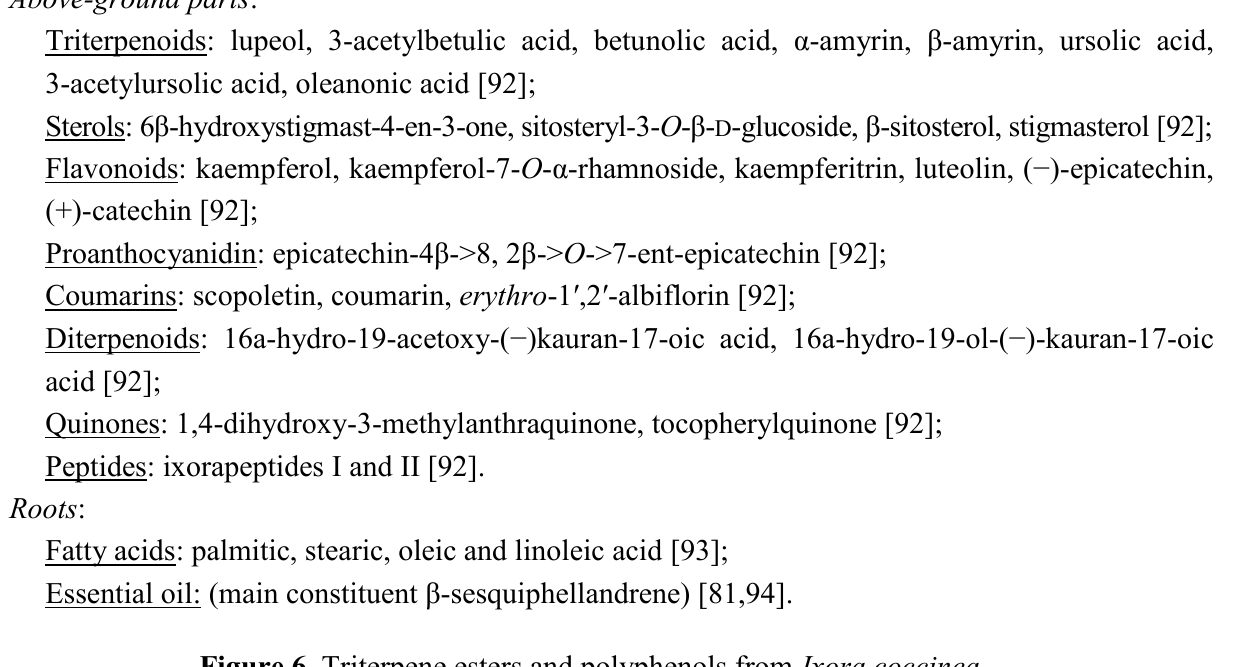
(CH ) 3 2 14 (CH ) 3 2 12